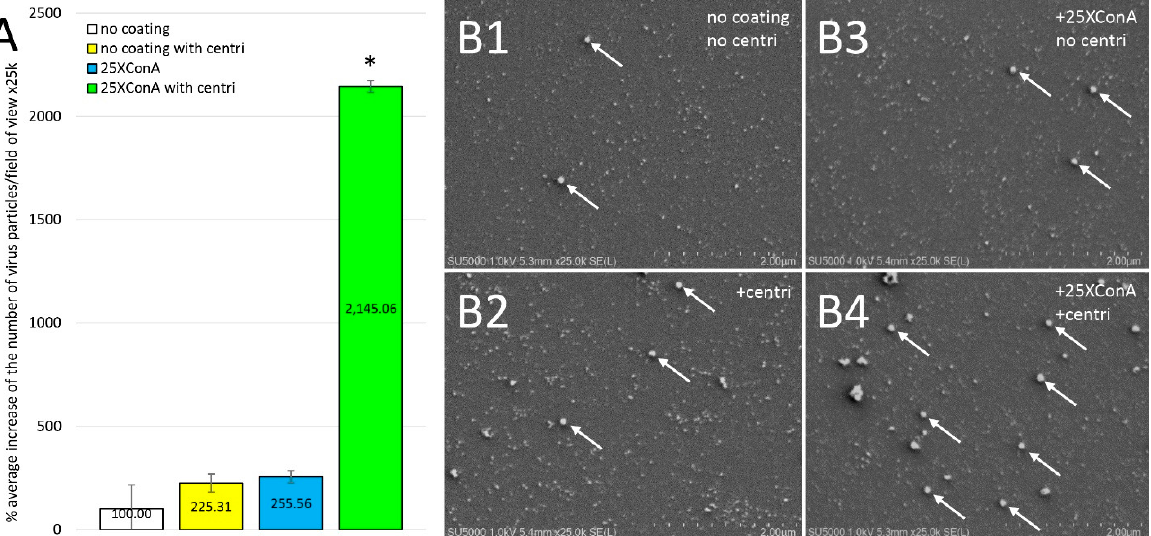
Figure 3. Effect of centrifugation and 25XConA coating on the deposition of SARS-CoV-2-like particles in shell vials. ( A ): Quantification of the amount of SARS-CoV-2-like particles deposited on non-coated 12 mm glass slides with and without centrifugation and of the amount of SARS-CoV-2-like particles deposited on 25XConA-coated 12 mm glass slides, with and without centrifugation. ( B ): SEM images of single fields of view at x25k after depositing SARS-CoV-2-infected cell culture supernatant, with ( B2 , B4 ) and without ( B1 , B3 ) centrifugation and with ( B3 , B4 ) and without ( B1 , B2 ) 25XConA coating. Error bars represent standard deviations. *: p -value < 0.05, Student’s t -test. The arrows point to Sars-CoV-2 virus-like